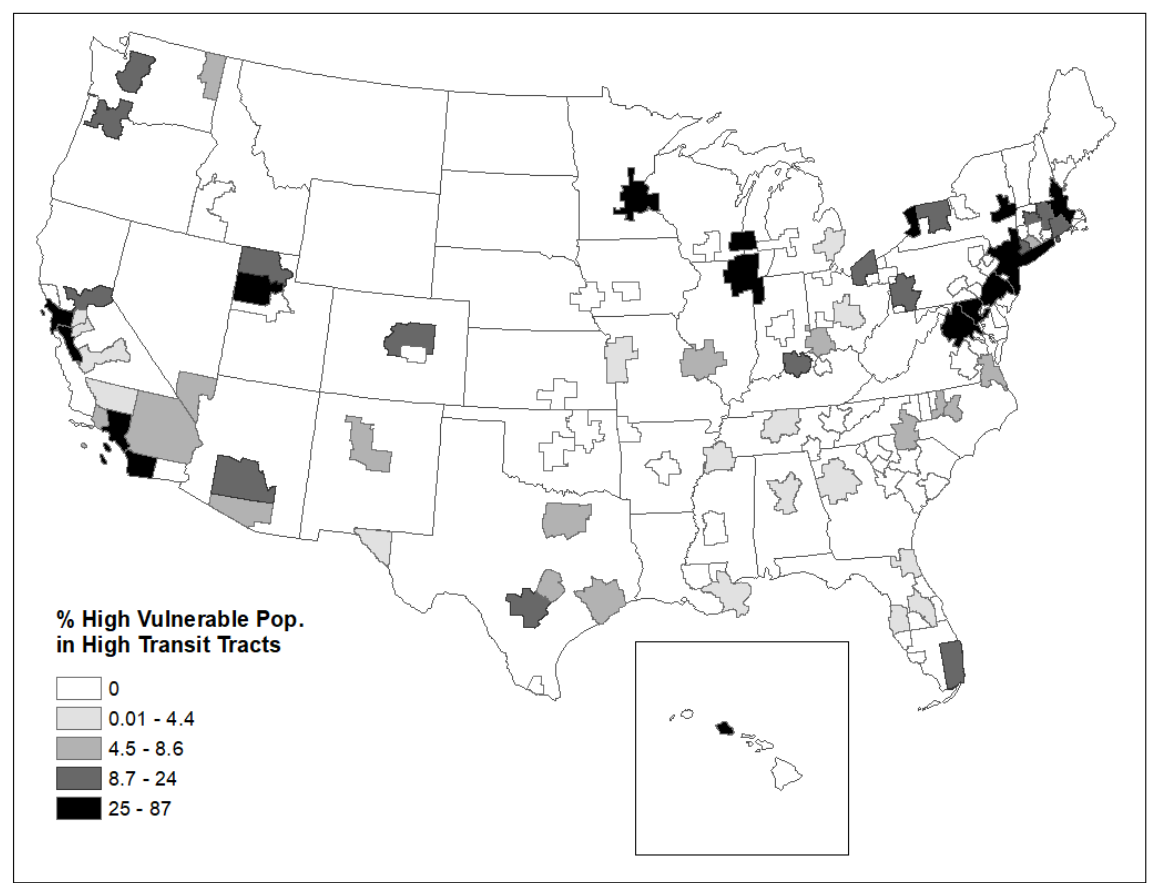
Figure 5. Percentage of urban population residing in high (80th percentile)-socially vulnerable (SV) census tracts also residing within high-transit (transit score ≥ 50 or within 1 km of a rail stop) census tracts by metropolitan area.